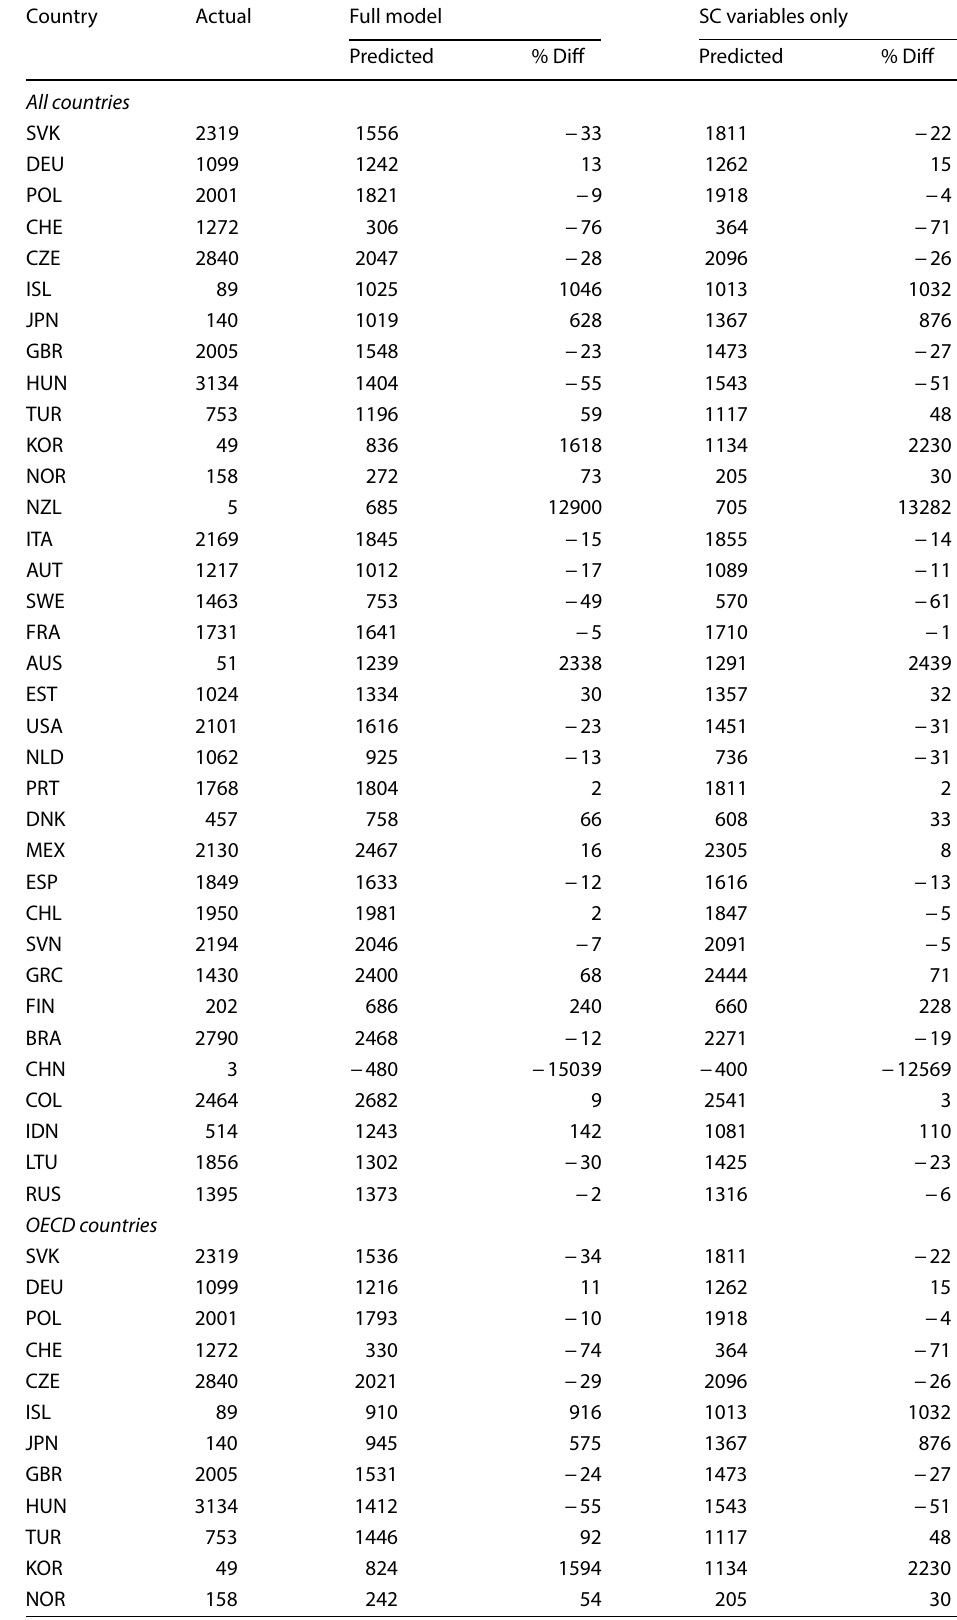
Table 10 Actual and predicted values for full period (values refer to deaths per